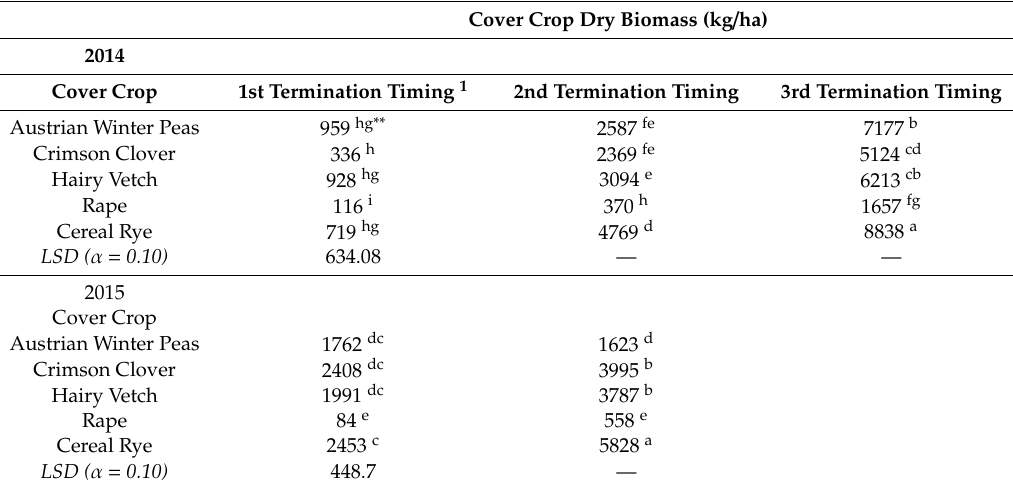
Table 2. Cover Crop Biomass at Three Termination Timings, E.V. Smith 2014 and